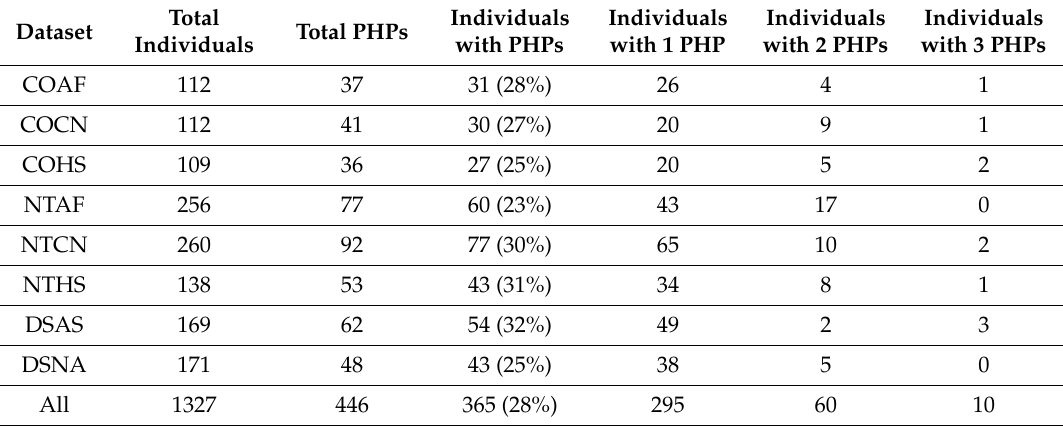
Table 5. Number of individuals with observed point heteroplasmies (PHPs) in each